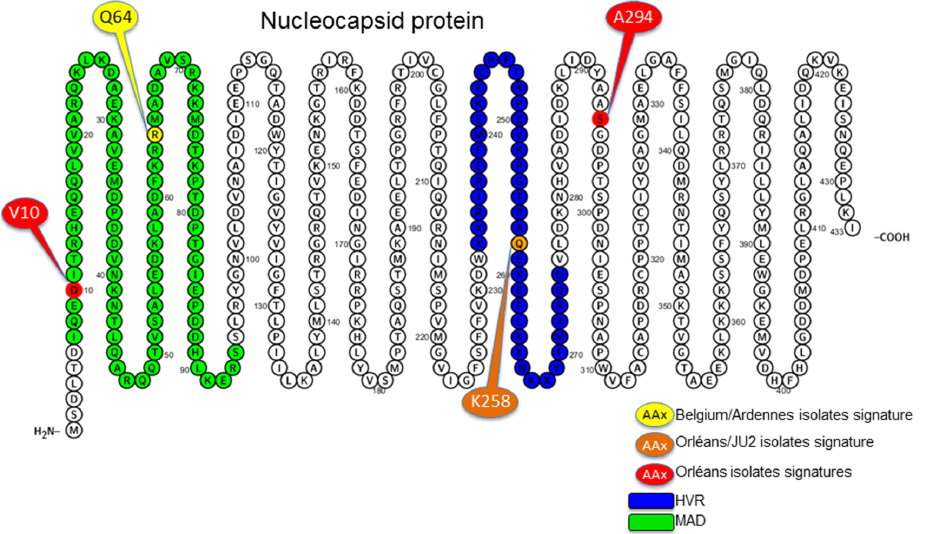
Figure 4. PUUV nucleocapsid protein aa sequence visualized with Protter—visualize proteoforms [31]. The used aa sequence corresponds to the consensus sequence of the S sequences dataset. The major antigenic domain (MAD) is represented in green and the hyper variable region (HVR) in blue.